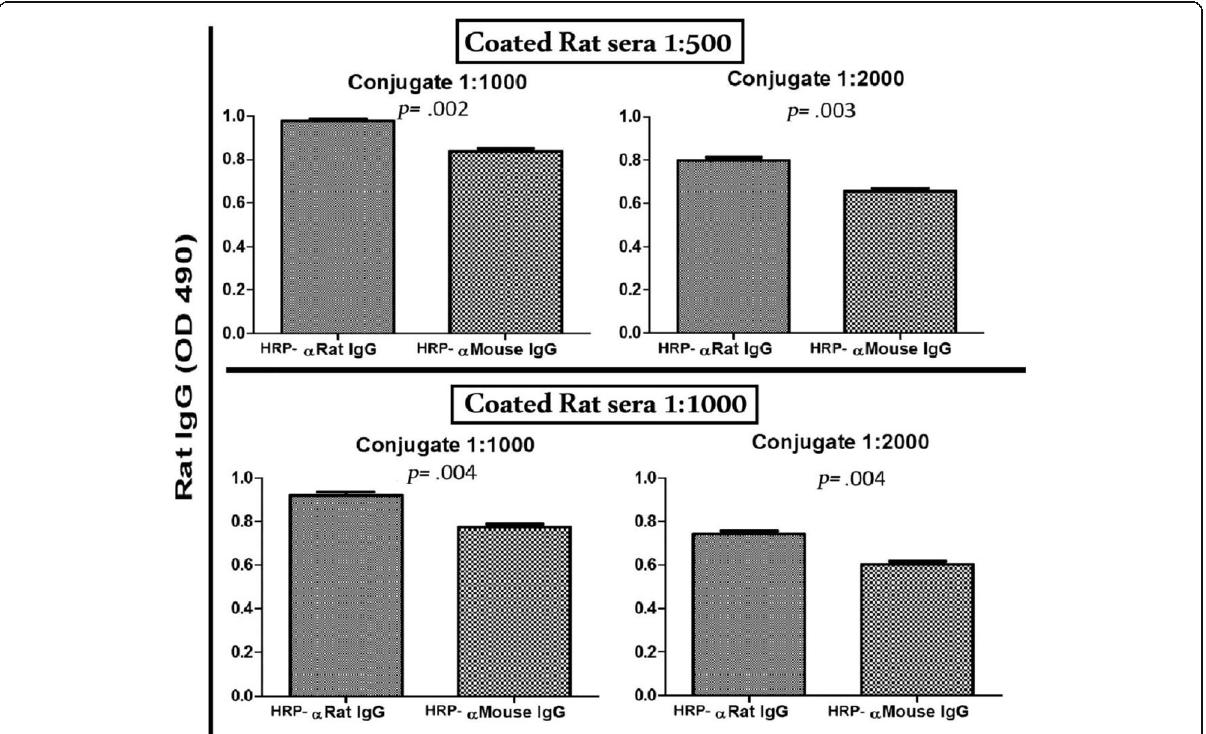
Fig. 1 Reaction between individual rat serum (represented as mean O.D.) and both HRP-conjugated anti-rat IgG and HRP-conjugated anti-mouse IgG: Rat sera ( n = 5) were used at dilutions 1:500 and 1:1000 and both conjugated antibodies were used at dilutions 1:1000 and 1:2000. Using Student ’ s t -test, results at different conditions showed statistically significant differences between reactivities with the homologous compared to the heterologous sera. However, the cross-reaction between rat sera and HRP-anti mouse-IgG remained unexpectedly and unacceptably high upon increasing both sera dilution to 1:1000 and conjugate dilution to 1:2000 (levels of reaction with anti-rat IgG and anti-mouse IgG were 0.744 ±0.051 and 0.604 ±0.05, respectively, as Δ mean O.D. = 0.14; p=